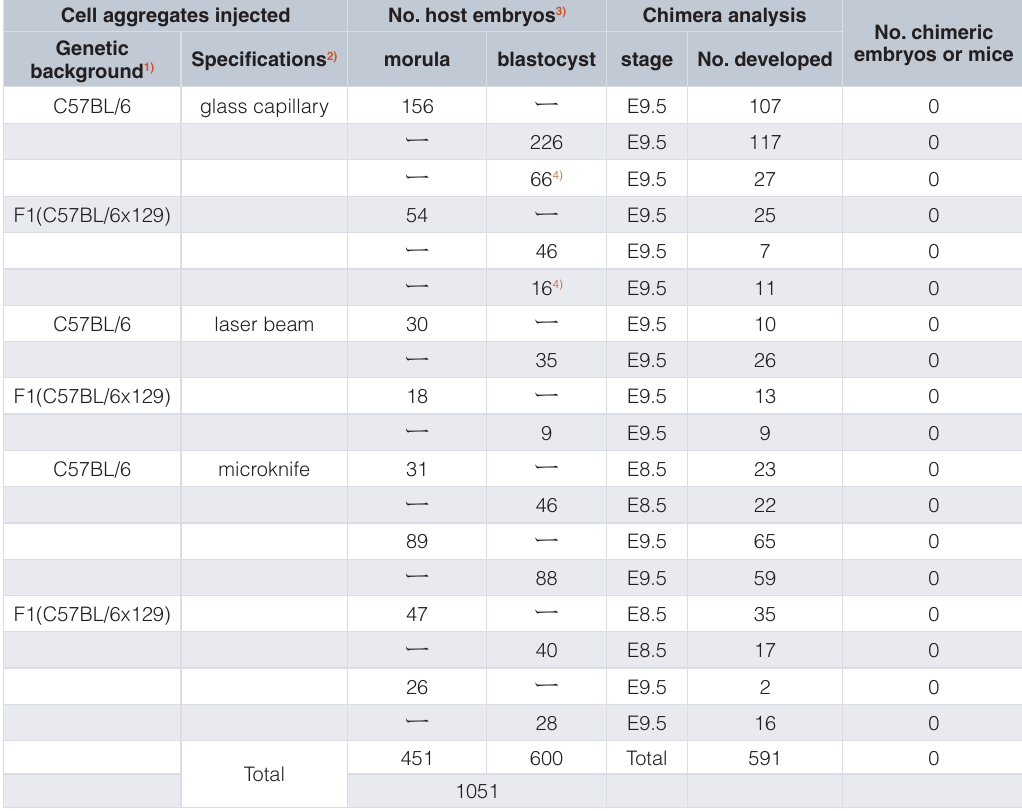
Table 2. Chimera analysis of